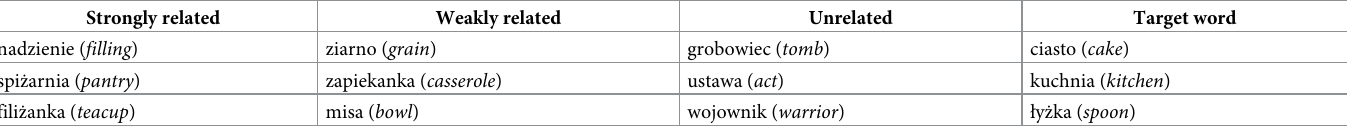
Table 2. Examples of strongly related, weakly related and unrelated prime words together with target words in Polish selected for Survey 1 and Survey 2 (transla- tions in English are provided in parentheses). Strongly related Weakly